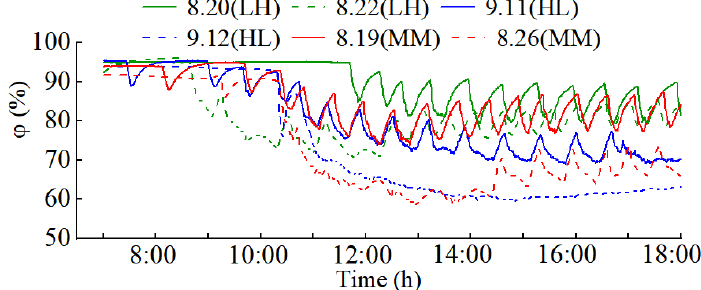
Figure 8. ϕ during the experimental period.